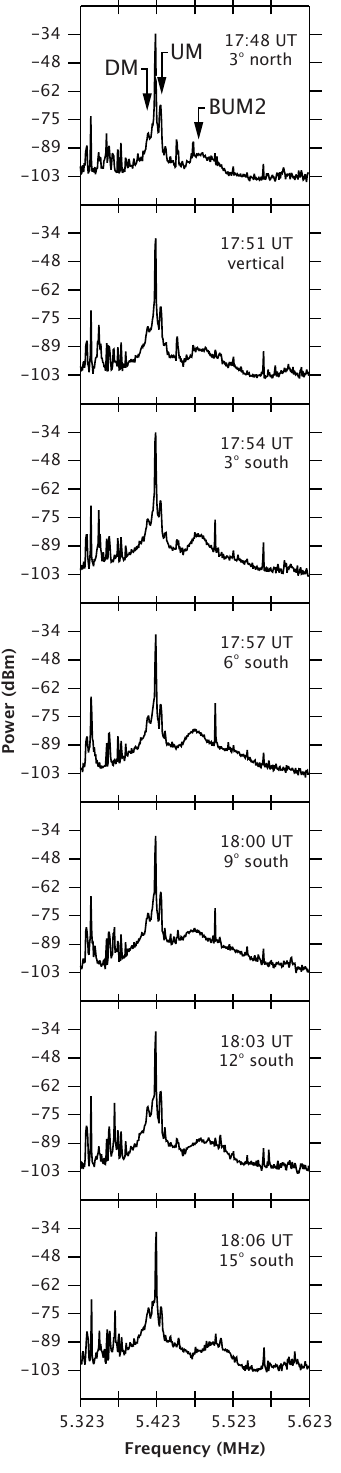
Fig. 10. SEE data during aspect angle scanning of the RF pump beam along the magnetic meridian. Time is in UT (local time mi- nus one hour). The pump frequency is 5.473MHz, near the fourth gyroharmonic. The SEE spectra have been integrated for 1min 45s during the 2-min pump-on